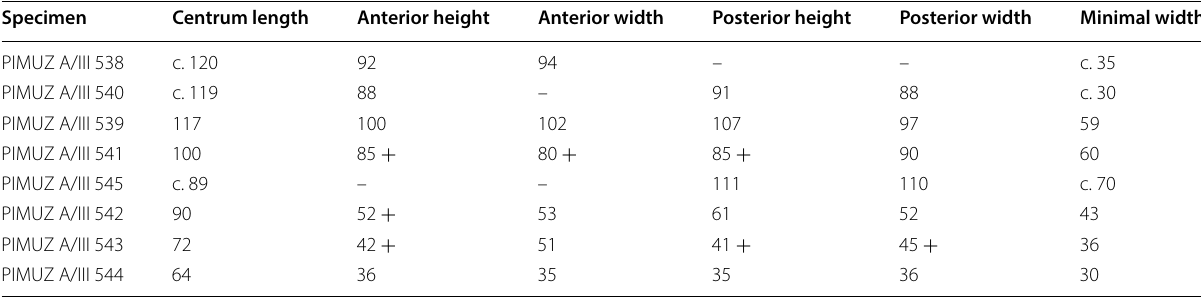
Measurements are in